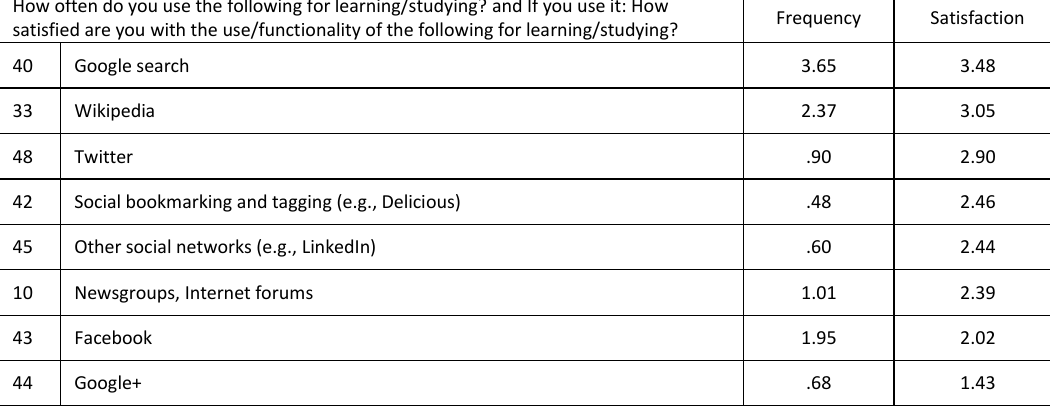
Table 11. Students’ answers to the questions: How often do you use the following for learning/studying? and